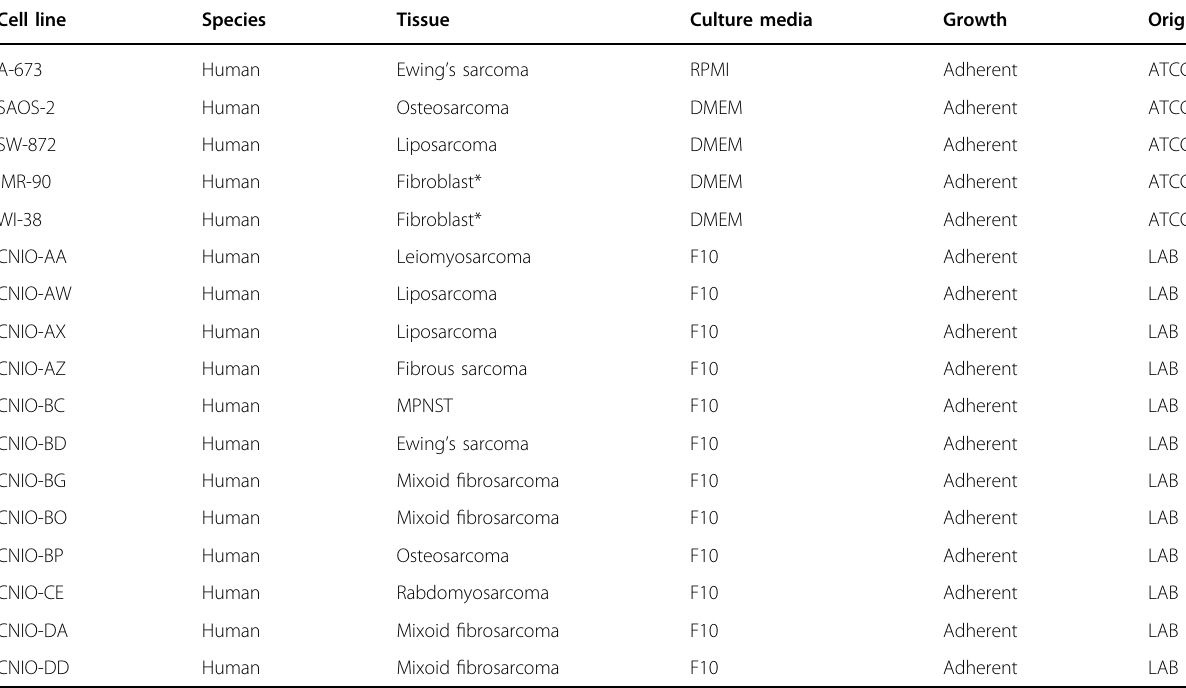
Table 2 The cell lines used in this study were obtained from the ECACC commercial repository or generated in the laboratory as previously reported 67 – 69